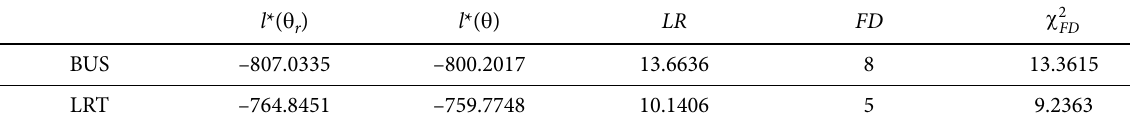
Table 7. Likelihood-ratio test for LRT vs. Car and Bus vs.